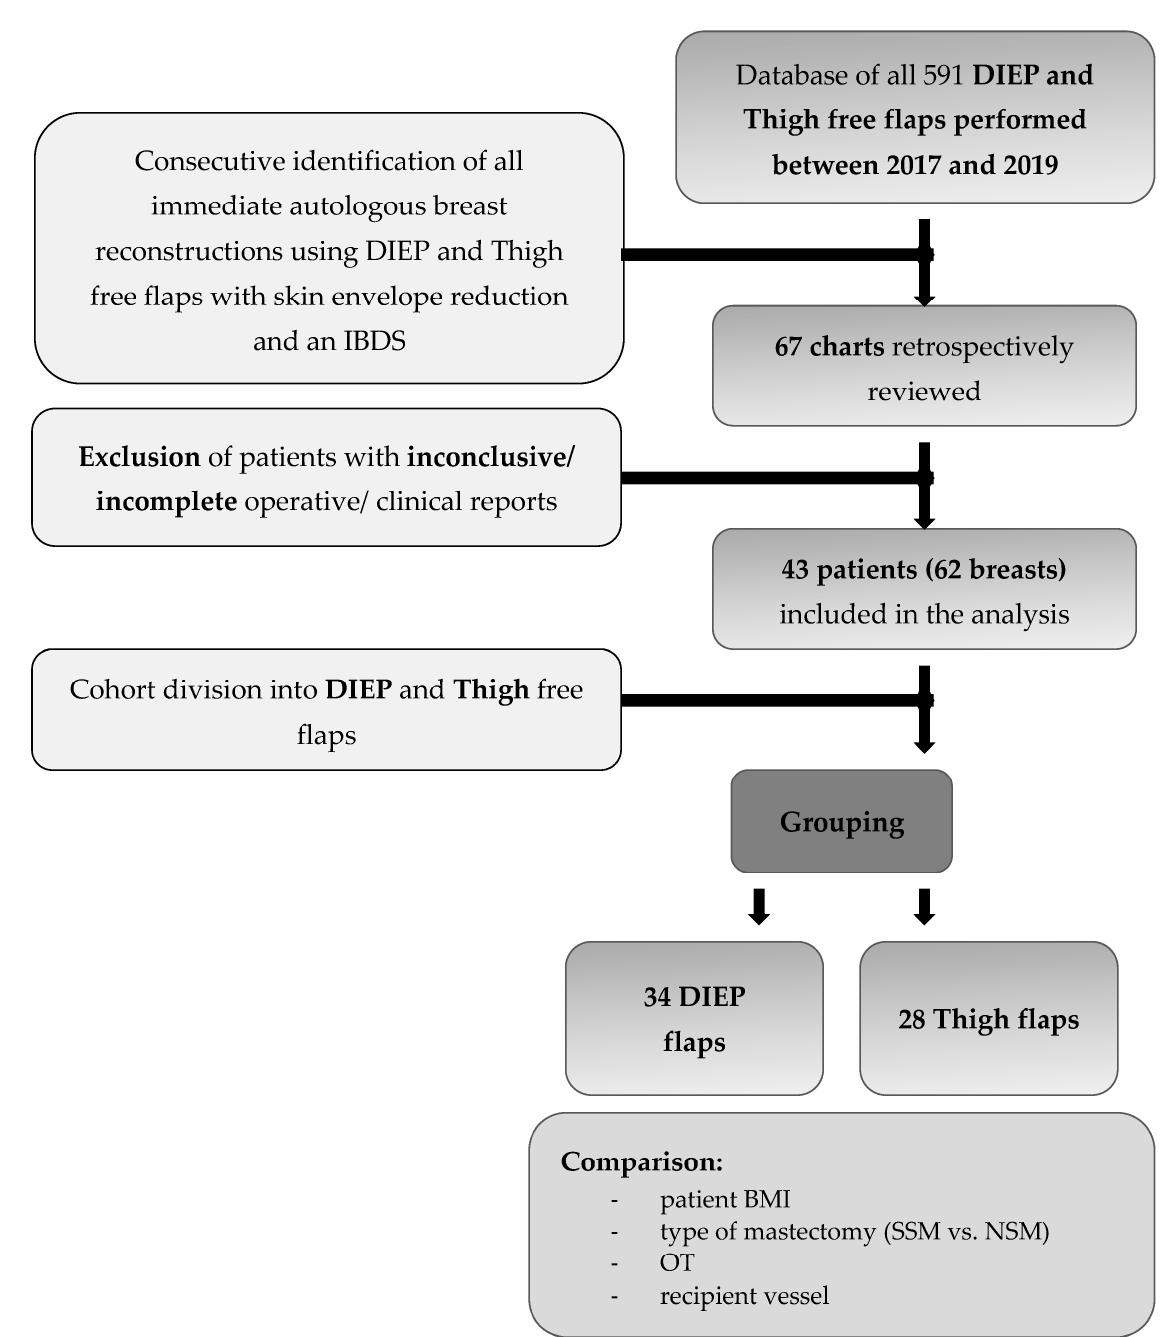
Figure 1. Consort Flowchart (DIEP, deep inferior epigastric artery perforator flap; Thigh, transverse myocutaneous gracilis flap or profunda artery perforator; BMI, body mass index; SSM, skin sparing mastectomy; NSM, nipple sparing mastectomy; OT, operation time).